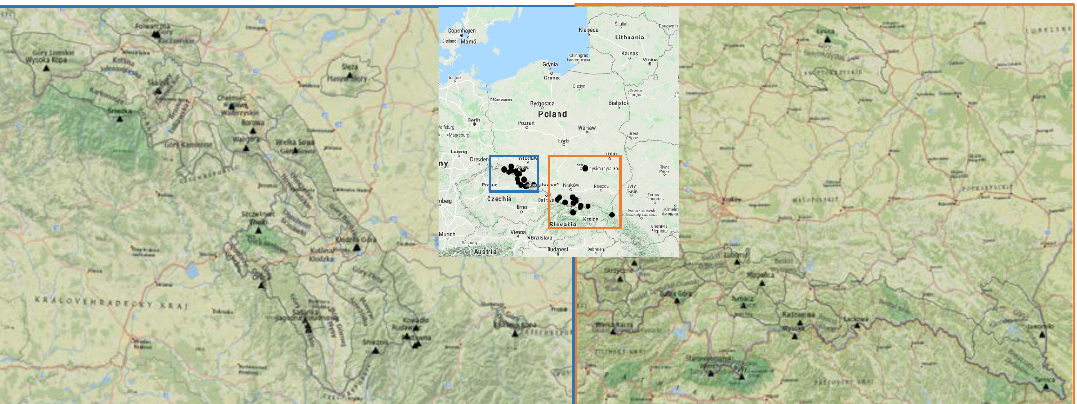
Figure 1. Distribution of the Crown of Polish Mountains (CPM) summits.